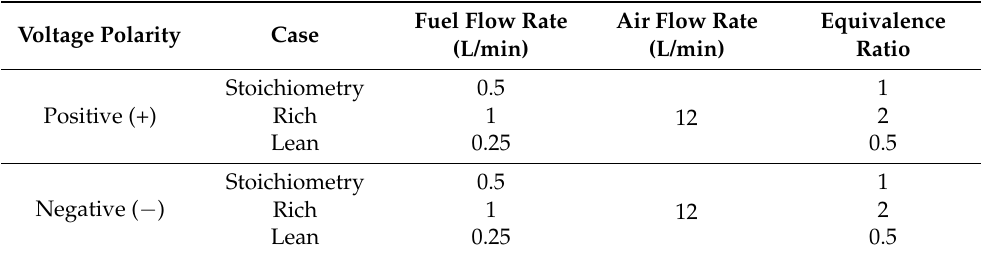
Figure 1. Experimental setup.